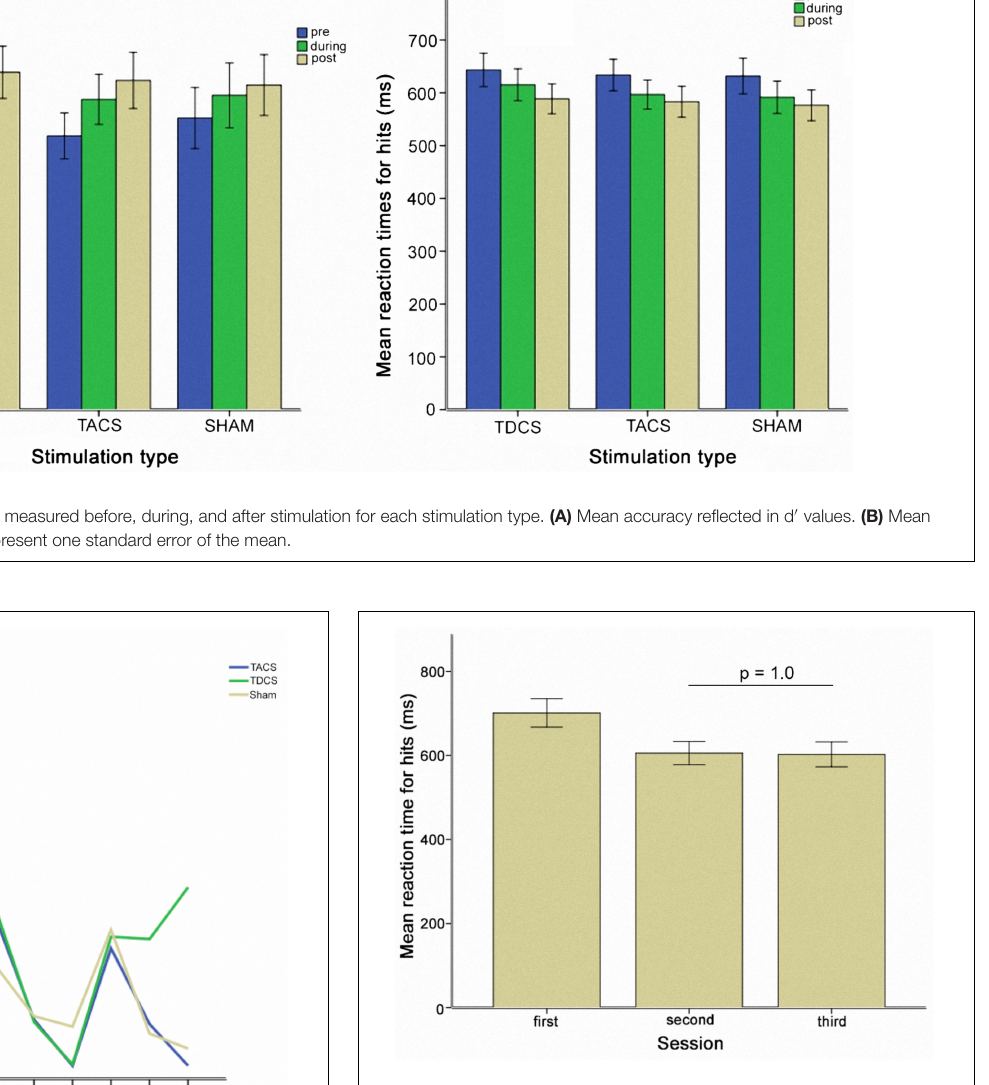
FIGURE 4 | Mean reaction times for hits prior to stimulation separately demonstrated for the three sessions. Error bars represent one standard error of the